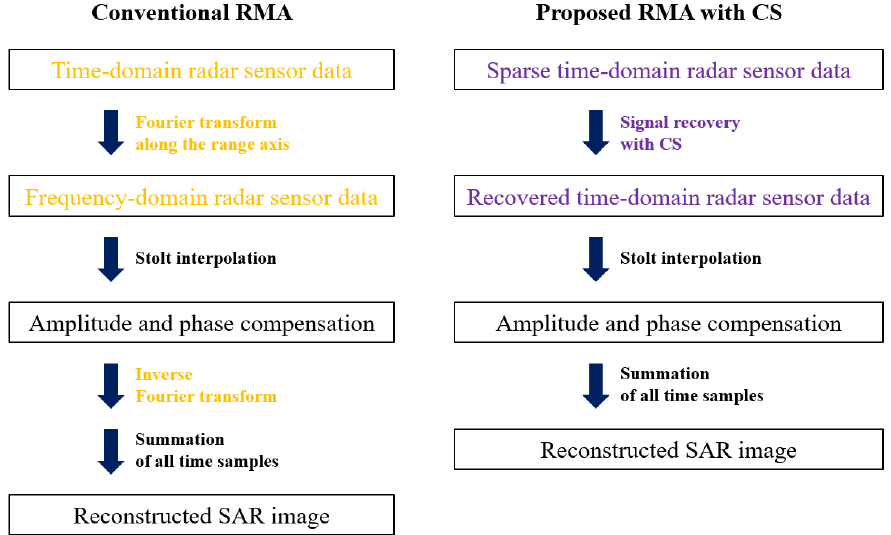
Figure 5. Conventional SAR image reconstruction using the RMA and the proposed CS-based SAR image reconstruction